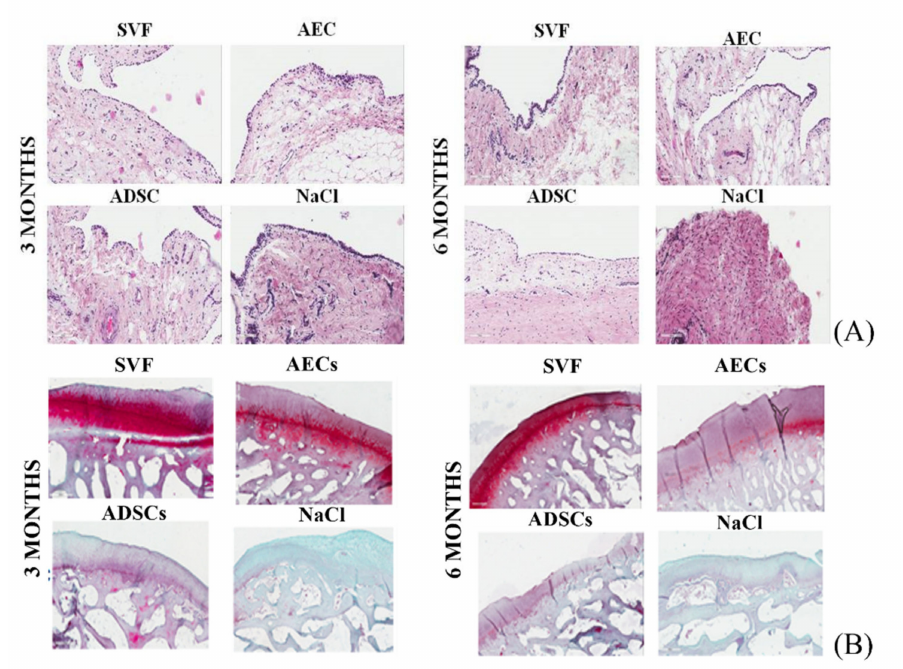
Figure 4. ( A ) Histological images of synovial membrane at 4 × magnification. Hematoxylin and eosin staining. ( B ) Histological images of lateral femoral condyle cartilage at 4 × magnification. Safranin O–Fast Green staining. Scale bar = 500 µ